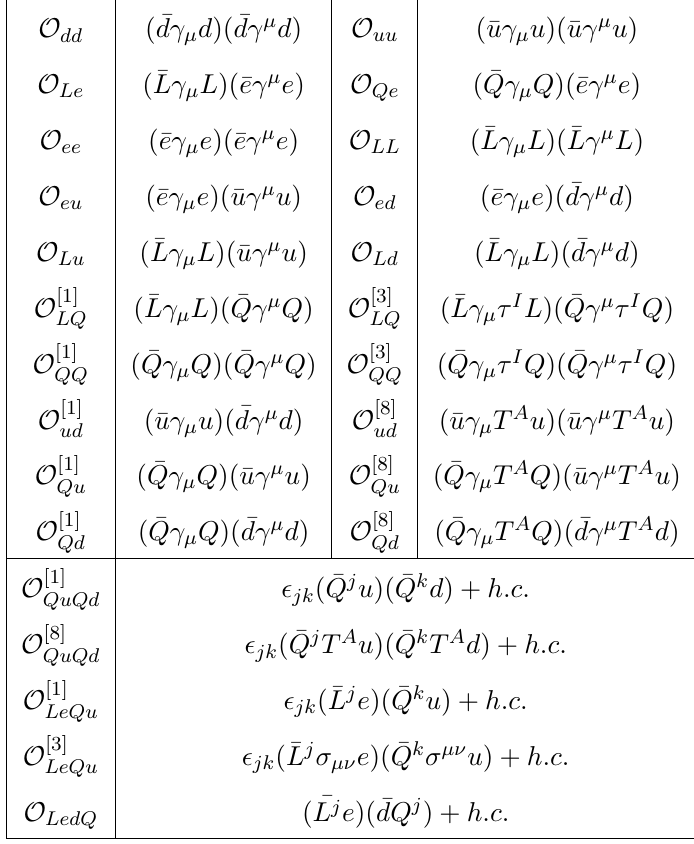
2 = 30] class of operators. Here j; k (cid:2)